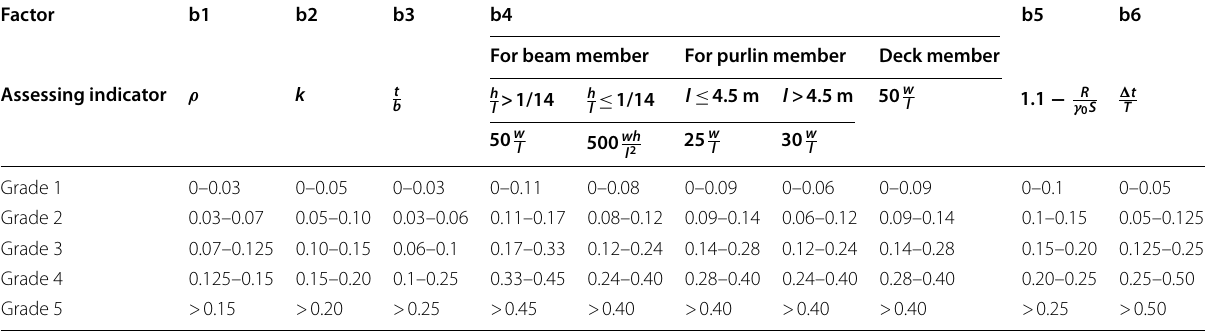
synthesizing the conditions of all assemblies. The grade levels of the entire structure and corresponding recommended interventions are presented in Table 3.